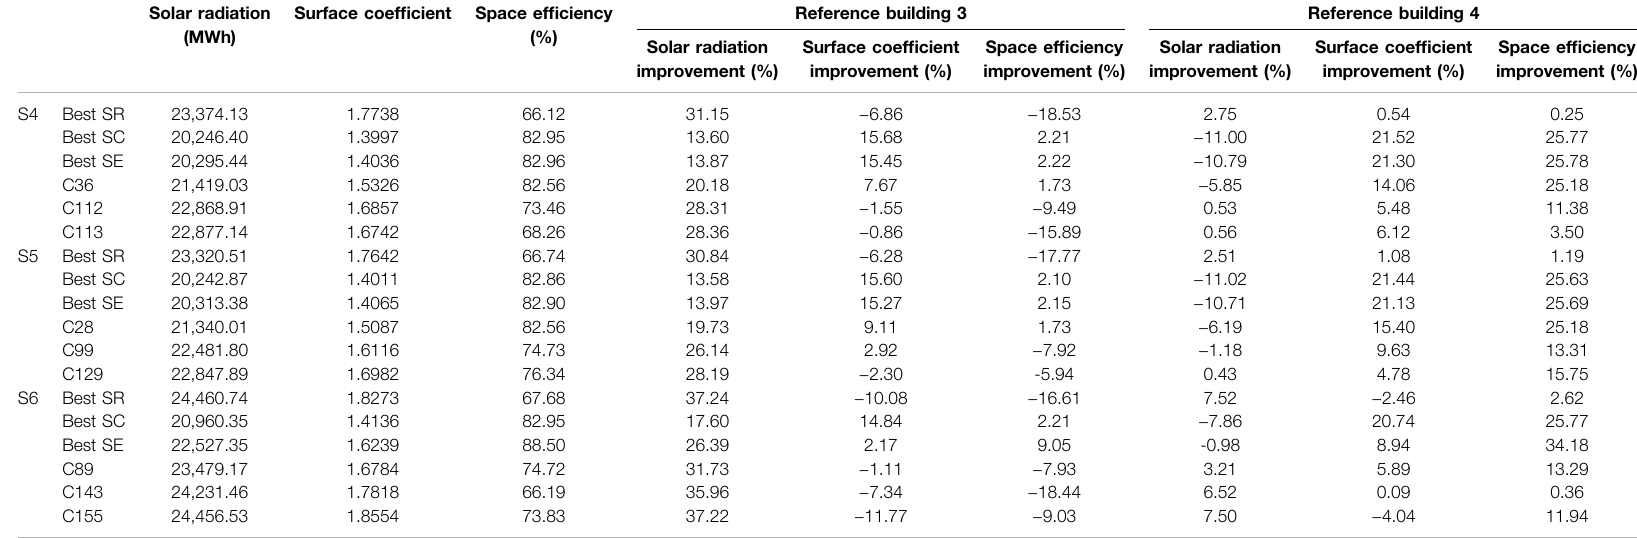
TABLE 5 | Performance of S4-S6 characteristic solutions and comparison with reference buildings 3 and 4. Solar radiation